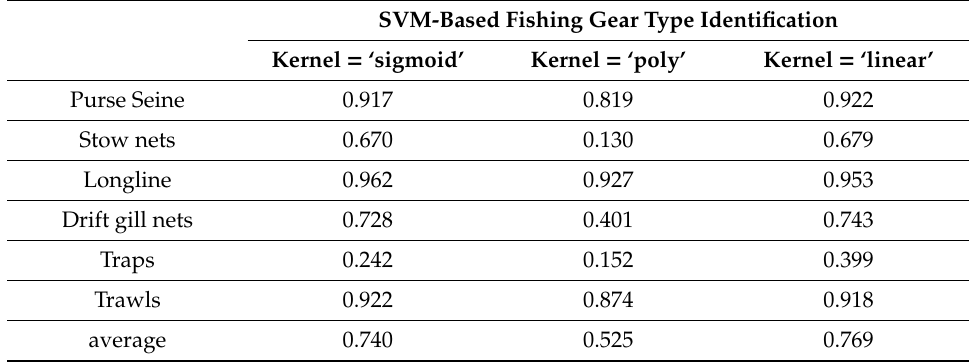
Table 4. The comparative experiments results of the support vector machine (SVM) model